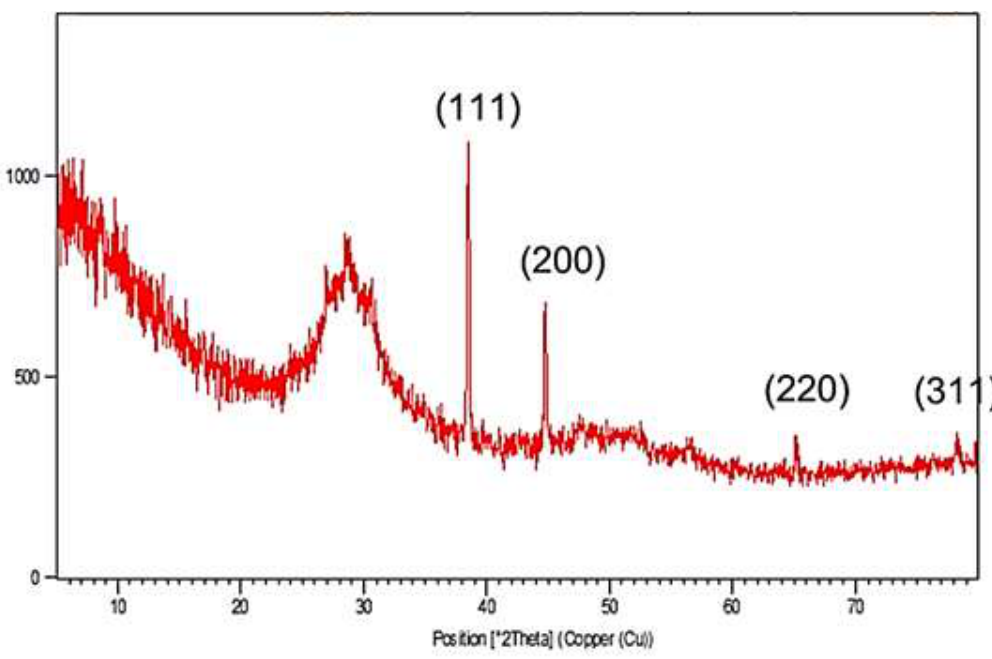
Figure 5: Characterization of silver nanoparticles using an X-Ray diffraction. 3.5. Study of the Antimicrobial Activity of Silver Nitrate and Silver Nanoparticles against Bacterial Isolates The results of studying the effect of silver nitrate by agar well diffusion method, when using different concentrations of 5mM AgNO (12.5%, 25%, 50%, 100%) in Tables 1 and Figure 6. showed that they had a slight effect on 3 S.haemolyticus and K.pneumoniae bacteria the highest inhibitory diameter in the current study was 14.6 mm at 100% concentrations (stock) against S.haemolyticus bacteria was followed by that of K.pneumoniae bacteria with an average inhibition zone diameter of 13.6 mm at 100% concentrations (stock) and that the minimum inhibition diameter in the current study was 11 mm at a dilution (12.5%) against K.pneumoniae bacteria, The inhibition zone diameter showed that silver nitrate was more effective against S. haemolyticus in comparison to K.pneomoniae bacteria , these results are in line with the finding of the previous study that reported AgNO was more effective 3 against Gram positive bacteria in comparison to Gram negative bacteria [31]. Table 1: Antibacterial activity of Silver nitrate and biosynthesized silver nanoparticles against two types of pathogenic